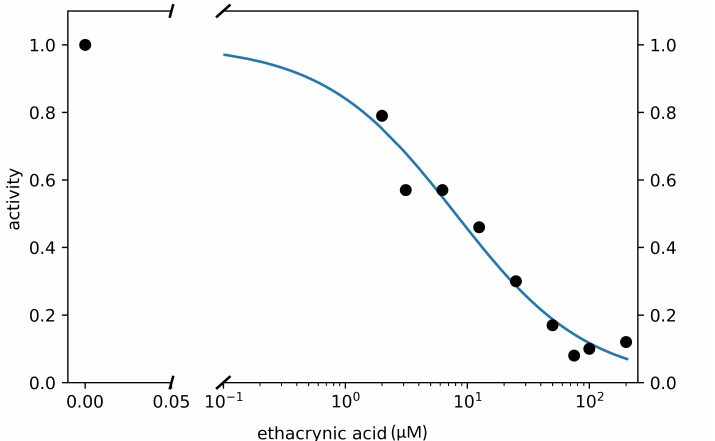
Figure 4. Time course of the SARS-CoV-2 M pro enzymatic activity. Left panel shows the enzyme activity in the DTT- containing reaction medium; black and red dots represent positive control and 100 µ M ethacrynic acid, respectively. Right panel reports the enzyme activity in the DTT-free reaction medium; black and red dots represent positive control and 100 µ M GC376, respectively. Reported traces are the average of three experiments.